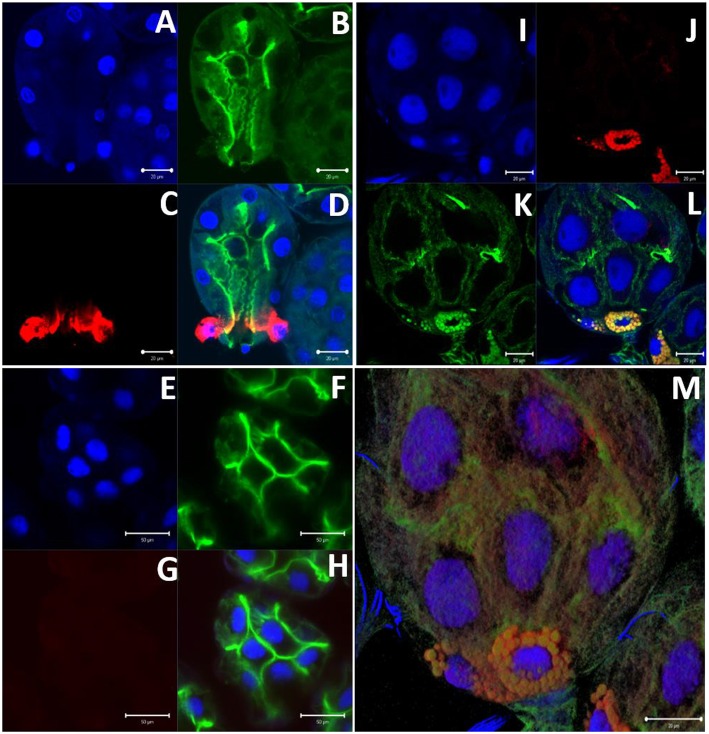
α-gal immunolocalization in partially-fed Ix. scapularis (IS), Am. maculatum (AM), and Am. americanum (AA) salivary glands. Ix. scapularis salivary gland images (63×) using DAPI (A), phalloidin-stained F-actin (B), alpha-gal IgM (C), and merged images (D). Am. maculatum salivary gland images (40×) using DAPI (E), phalloidin-stained F-actin (F), anti-α-gal IgM (G), and merged images (H). Am. americanum salivary gland images (100×) using DAPI (I), alpha-gal IgM (J), phalloidin-stained F-actin (K), merged images (L), and 100× 3D projection from Z-stack (M).